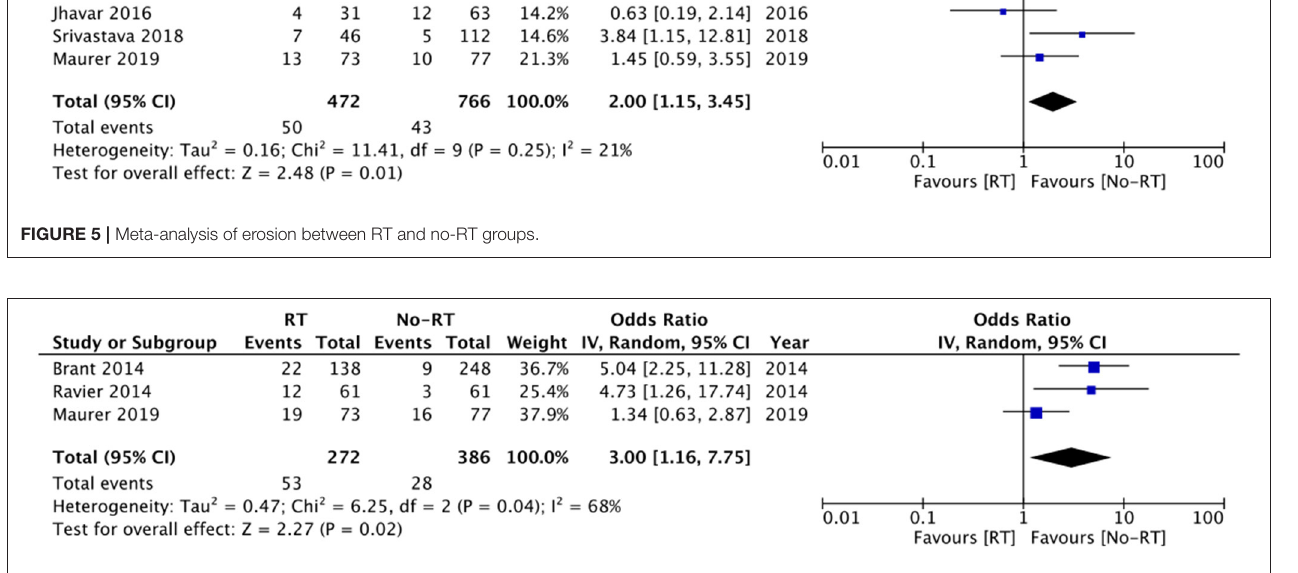
FIGURE 6 | Meta-analysis of explantation between RT and no-RT